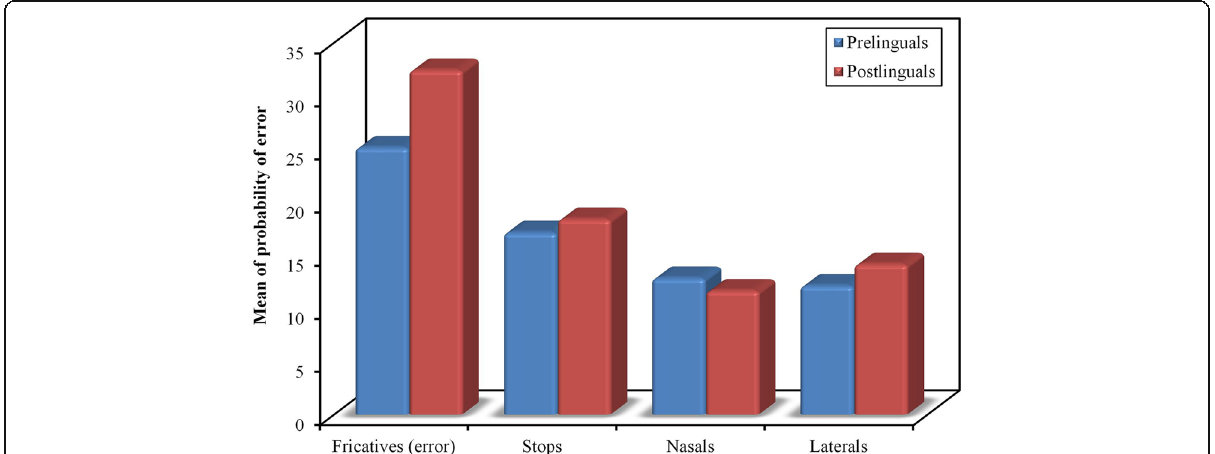
Fig. 2 Bar chart describing the probability of error of consonants in pre- and postlingual CI users